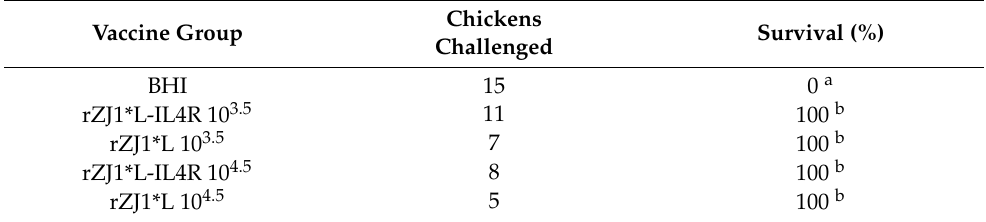
Figure 4. Effect of rZJ1*L-IL4R vaccination at 18 DOE on Post-Challenge Viral Shedding. At 18 DOE, SPF embryonated chicken eggs were vaccinated in ovo with 10 3.5 EID 50 /egg (L) or 10 4.5 EID 50 /egg (H) of rZJ1*L-IL4R, rZJ1*L, or brain heart infusion (BHI) control. At 21 DPH, chicks were challenged Table 2. Effect of rZJ1*L-IL4R vaccination at 18 DOE on Post-Challenge Survival. with 10 5 EID 50 vZJ1 via the oculo-nasal route. Viral titers from the oropharyngeal (OP) and cloacal (CL) routes were measured at 2 ( a ) and 4 ( b ) DPC. Mean of groups were compared using One-way Chickens ANOVA followed by a multiple comparisons Tukey’s test with a level of significance of p ≤ 0.05. Survival (%) Vaccine Group Challenged Groups with different letters are significantly different. Reference line denotes the average limit of detection.